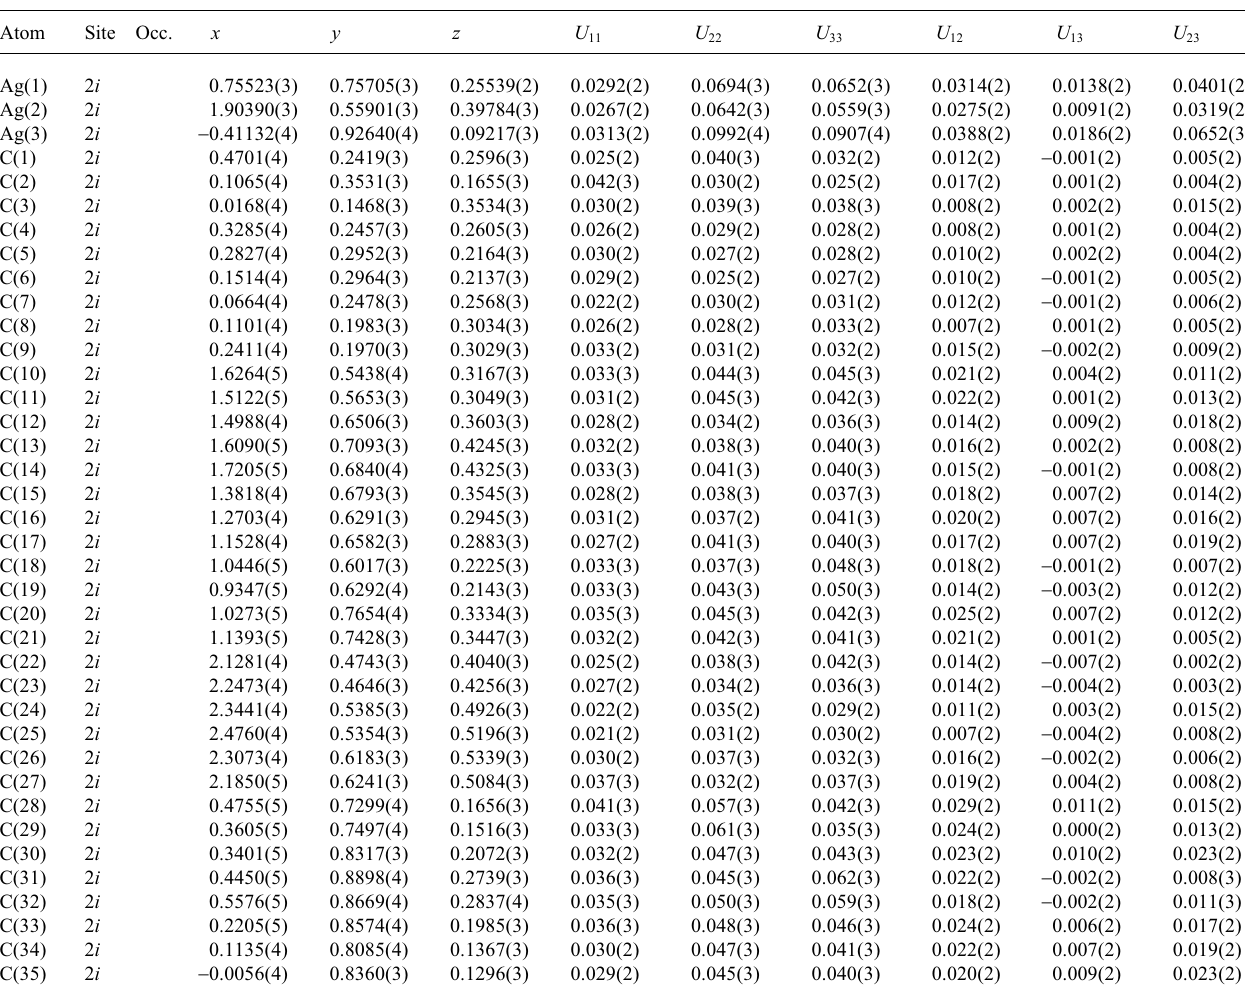
Table 3. Atomic coordinates and displacement parameters (in Å 2 ) .